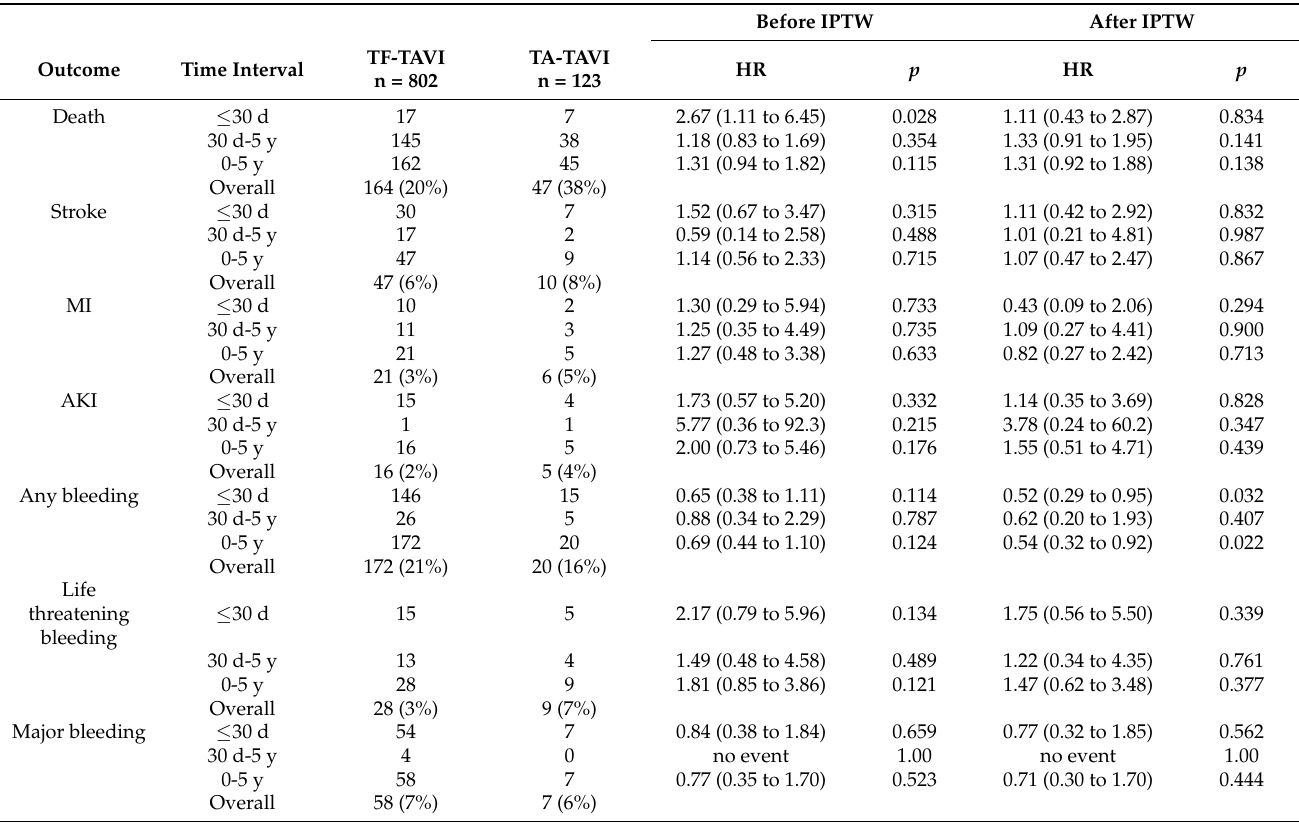
Table 4. Short and long-term follow up (landmark 30